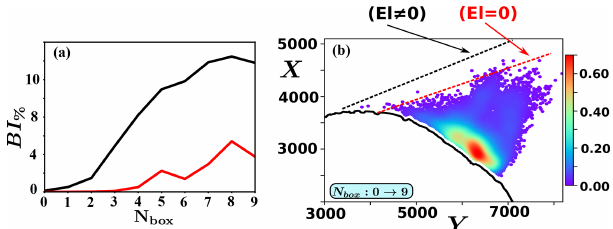
Figure 6. FCE configuration: characteristics of the ion foreshock with and without the electrostatic field component (cid:101) E l (i.e., (cid:101) E l x = (cid:101) E l y = 0). Panel (a) shows the percentage of the back-streaming ions BI % versus the box number. Black and red lines are defined for (cid:101) E l (cid:54)= 0 and (cid:101) E l = 0, respectively. Panel (b) shows the density of the back-streaming particles in the same format as Fig. 3 but when (cid:101) E l = 0. Only the view which aggregates all boxes (i.e., N Box = 10) is shown in order to evidence the location of the edge of the ion foreshock (dotted line) in each